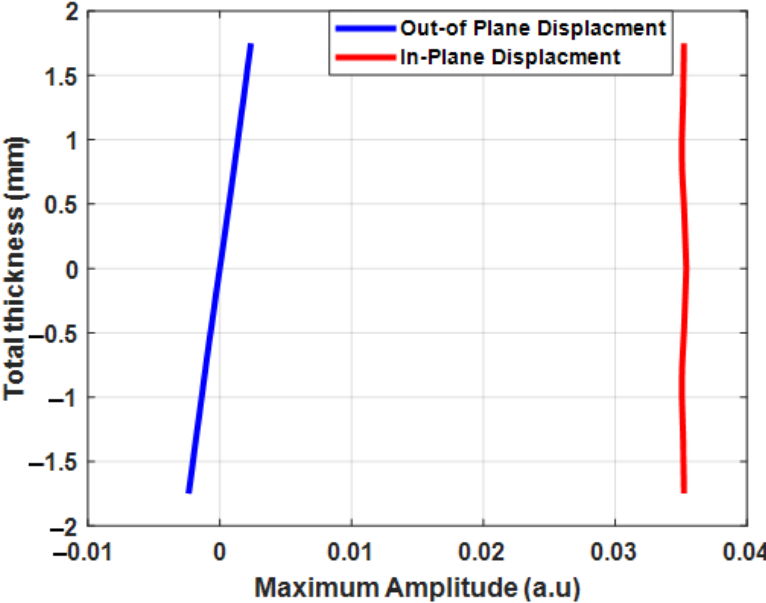
Figure 4. Through-thickness displacements and the maximum amplitude of the S (cid:2868) mode in the 3.5 mm-thick CFRP